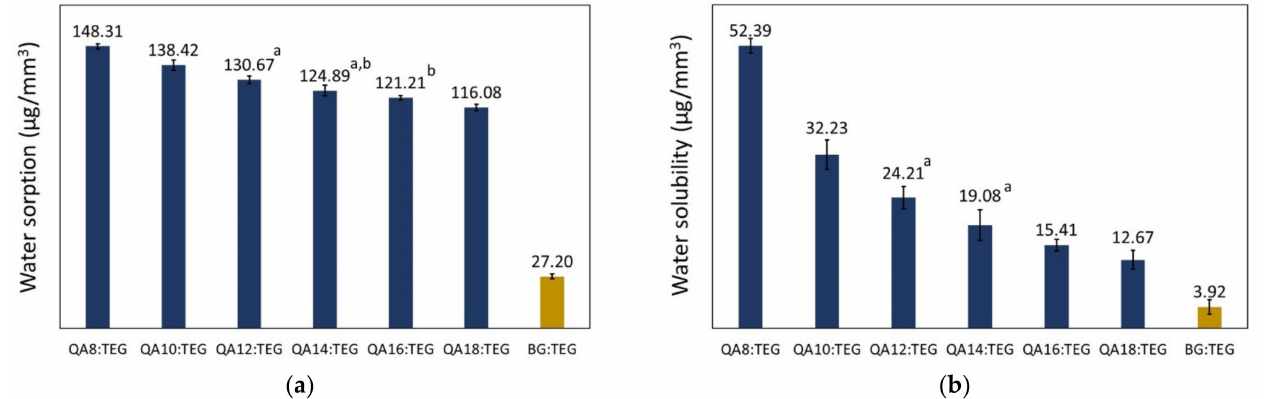
Figure 3. Water sorption ( a ) and water solubility ( b ) of the studied copolymers. Lower case letters indicate statistically insignificant differences ( p > 0.05, non-parametric Wilcoxon